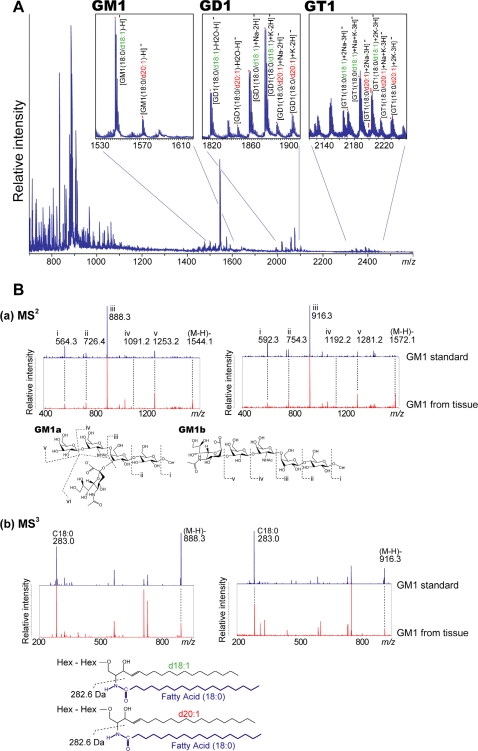
Direct MALDI-MS and MSn allows specific detection of ganglioside molecular species.A. Averaged mass spectra obtained from the entire hippocampal formation. In the spectra, the mass peaks corresponding to GM1, GD1, and GT1 are detected, and IMS provides distinct signals for molecular species containing C18- and C20-sphingosines. B. MSn structural analysis of ions corresponding to GM1. (a) MS2 product ion spectra show that the ions at m/z 1544 and 1572 had the same oligosaccharide structure, i.e., they contained a sialic acid moiety, but the ceramide mass peaks were observed at different m/z values. (b) MS3 product ion mass spectra of m/z 888.3 and 916.3 were obtained to determine the different structural constituents in the ceramide moieties. Because of the detection of m/z 283.0 (fatty acid-related ion) in both the spectra, the 28-u difference between m/z 1544 and m/z 1572 was attributed to the difference in the sphingosine constituent; m/z 1544 had C18-sphingosine and m/z 1572 had C20-sphingosine.